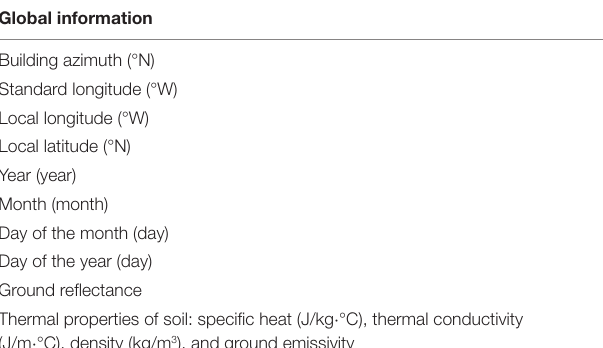
FigUre 7 | ambient air temperature for case study .